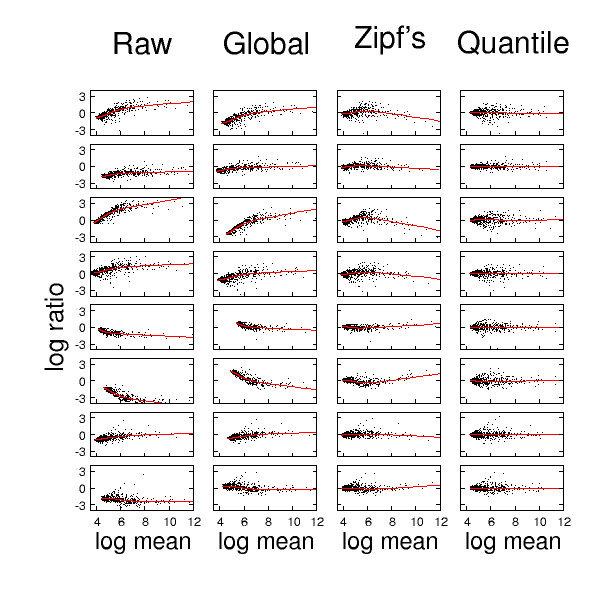
Clontech microarray MA plots. MA plots of Raw Clontech Rat data compared to data normalized with the Global mean, Zipf's, and Quantile methods (columns). Each row of plots represents one pairwise comparison, only 8 of the possible 10 pairwise comparisons of the 5 microarrays used in Additional file 1 are shown. Lowess curves are plotted in red.